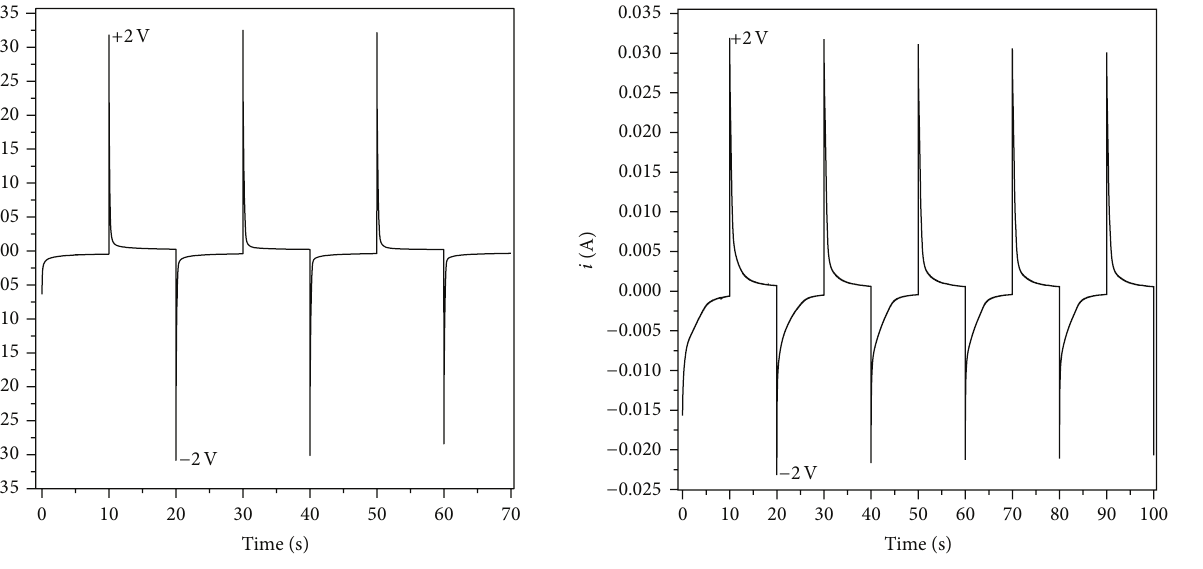
Figure 6: Chronoamperometric profile of a WO 3 /PE/ITO ECD Figure 7: Chronoamperometric profile of a WO 3 /PE/V 2 O 5 ECD. device. Electrodes configuration: WO 3 /ITO/Glass as working and Electrodes configuration: WO 3 /ITO/Glass as working electrode and ITO/PET as counter and reference electrode. 𝐸 1 = −2.0 V, 𝐸 2 = V 2 O 5 /ITO/PET as counter and reference electrode. 𝐸 1 = −2.0 V, = 𝑡 = 10 s. +2.0 V versus ITO electrode. 𝑡 𝐸 1 2